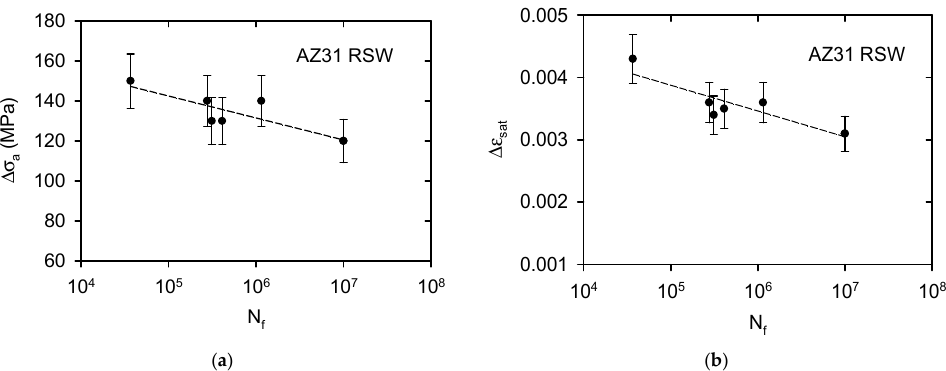
Figure 12. Relation between the stress amplitude and the number of cycles to fracture ( a ), the strain